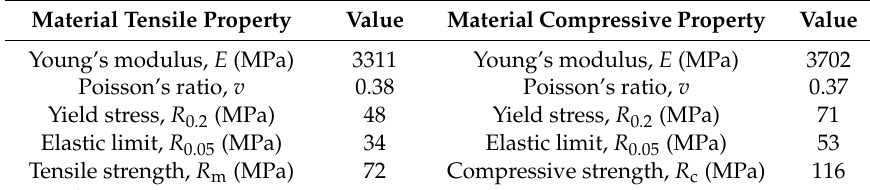
Table A1. PMMA’s properties at a displacement rate of 0.02 mm / s [26].